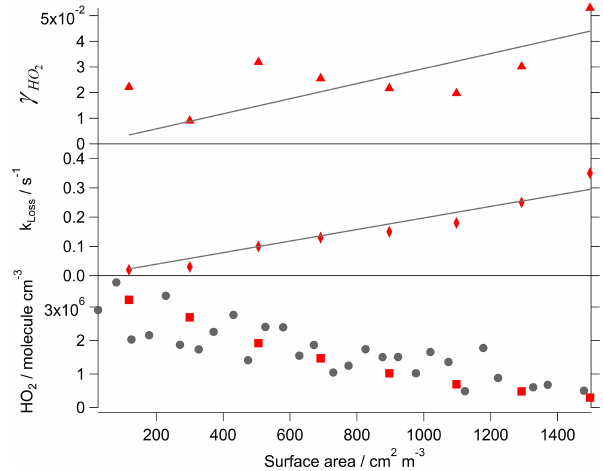
Figure 6. Upper panel. Average measured (solid red line) and sim- ulated (dashed red line) diurnal profile of HO 2 concentrations out- side of cloud events. The simulation is based on an expression orig- inally determined by Carslaw et al. (1999) and described further in Sect. 2.2. The shading highlights the sensitivity of the model to ± 1 σ changes in the CO and HCHO concentrations used as con- straints. Lower panel. Average measured (solid grey line) and mod- elled (dashed black and blue lines) diurnal profile of HO 2 concen- tration during cloud events. The model was run without (grey) and with (blue) a loss of HO 2 to cloud droplets equal to a first-order loss rate of 0.14s − 1 . The shading highlights the sensitivity of the model to ± 1 σ changes in the CO and HCHO concentrations used as constraints.